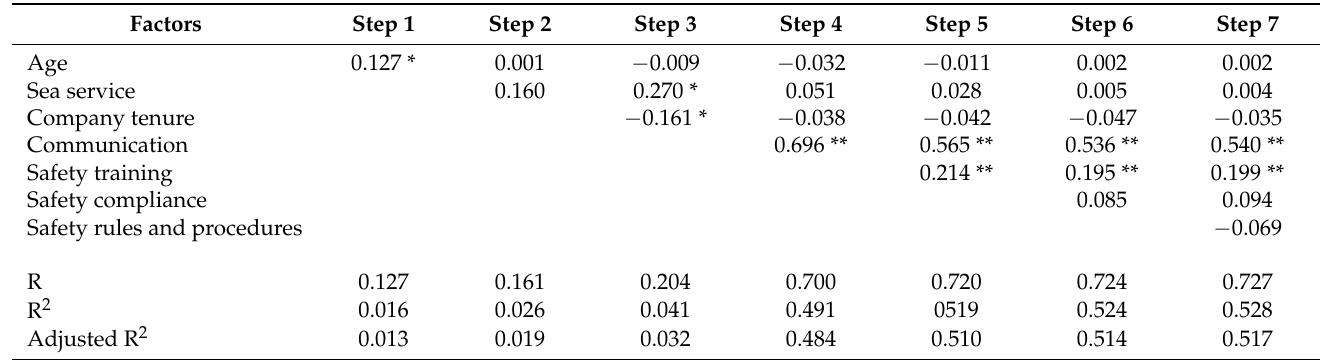
Table 4. Hierarchical multiple regression analysis predicting quality of safety supervision (standard- ized Beta